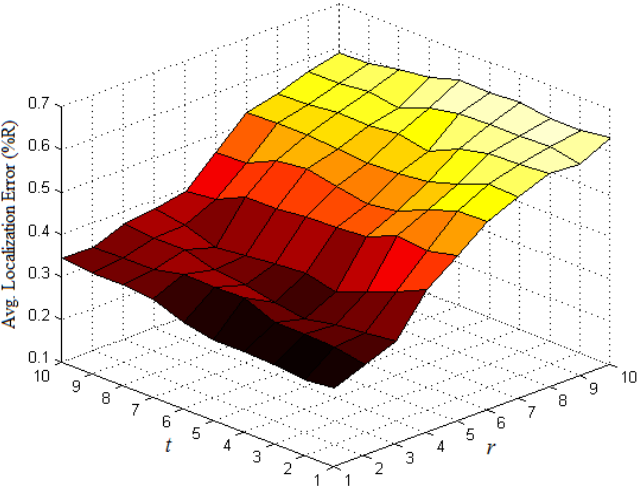
Figure 6. Average localization error as a function of r and t (anisotropic